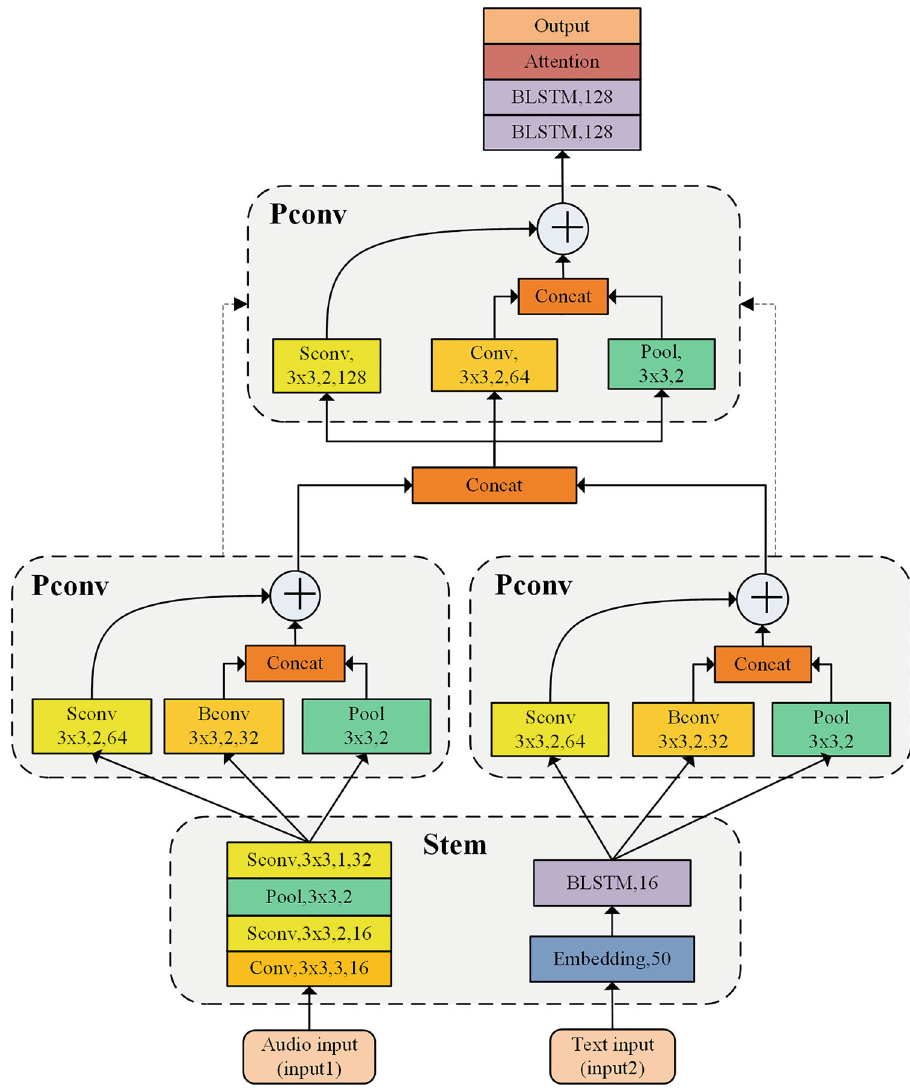
Fig. 4 Structure diagram of the fusion emotion recognition